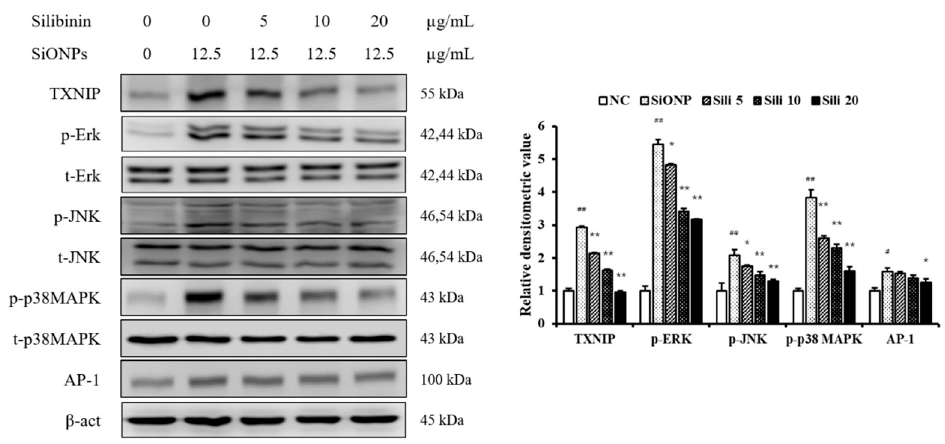
Figure 2. Effects of silibinin treatment on thioredoxin-interacting protein (TXNIP), mitogen-activated protein kinases (MAPK), and activator protein-1 (AP-1) expressions in SiONPs-induced NCI-H292 cells. Protein expression was determined by Western blotting analysis, and its densitometric value was assessed. Data are shown as means ± SD ( n = 3). ## p < 0.01 vs. non-SiONPs-induced NCI-H292 cells, * p < 0.05 and ** p < 0.01 vs. SiONPs-induced NCI-H292 cells, respectively.